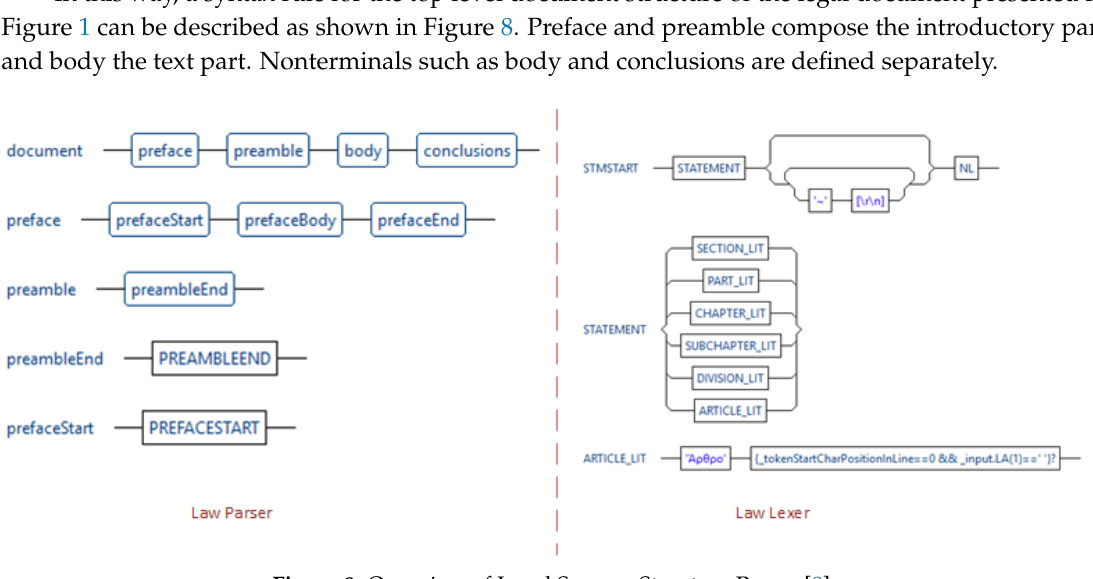
Figure 8. Overview of Legal Sources Structure Parser